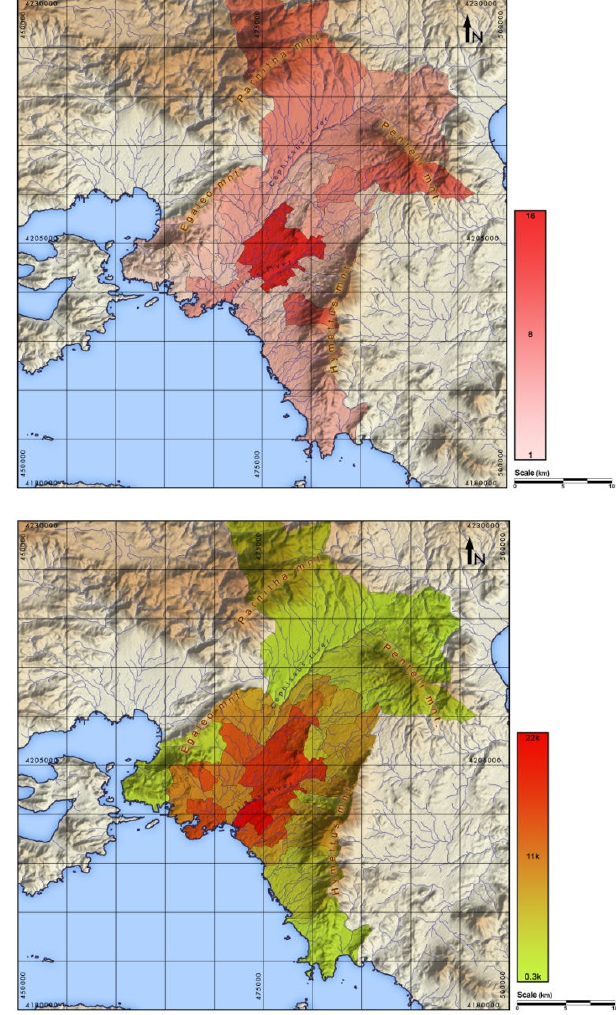
Figure 3. (a) Number of flash flood events for each one of the 15 sub-areas of the Athens-suburbs region. (b) Population density (people per sq. km of land area). (Created using QGIS and SRTM- v3 elevation data. Projection GGRS87. Area easting: 450000– 500000m. Area northing: 4180000–4230000m. Copyright NOA-